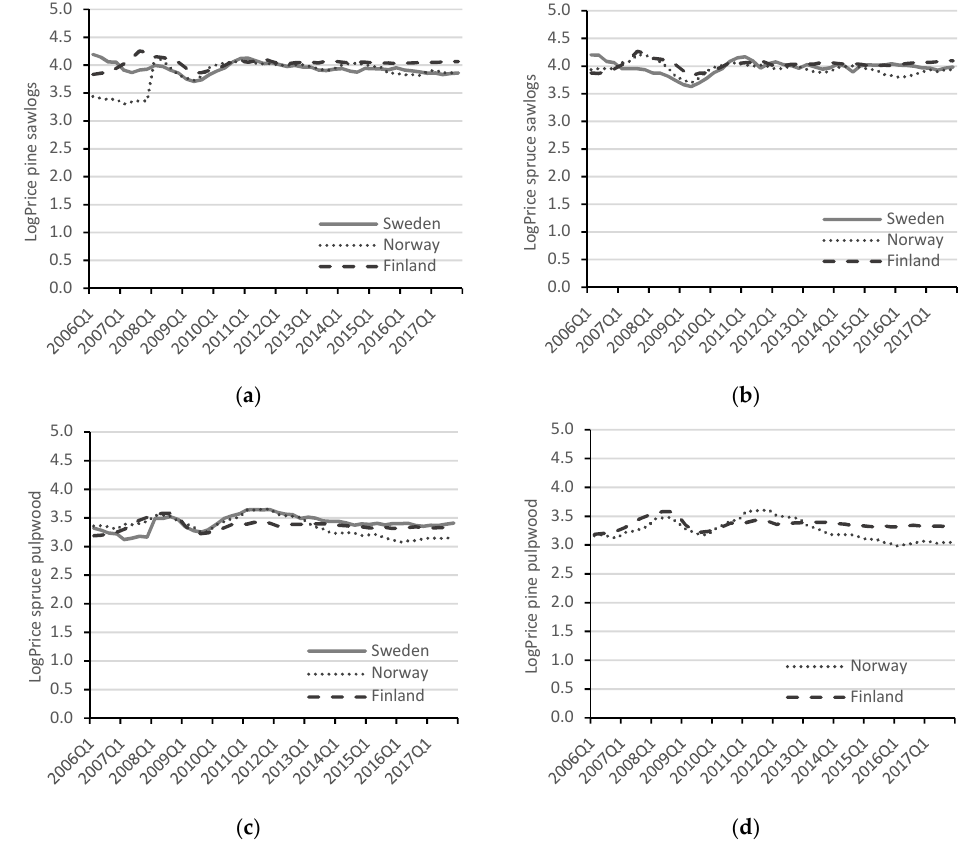
Figure 3. Logarithmic prices in Finland, Sweden and Norway between 2006 and 2018 for ( a ) pine sawlogs, ( b ) spruce sawlogs, ( c ) spruce pulpwood and ( d ) pine pulpwood.